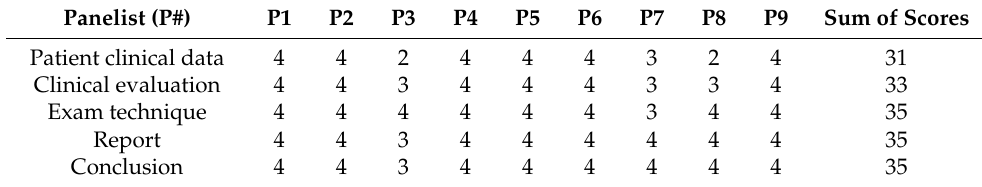
Table 1. Panelists’ single scores and sum of scores for RC staging reports (second round).